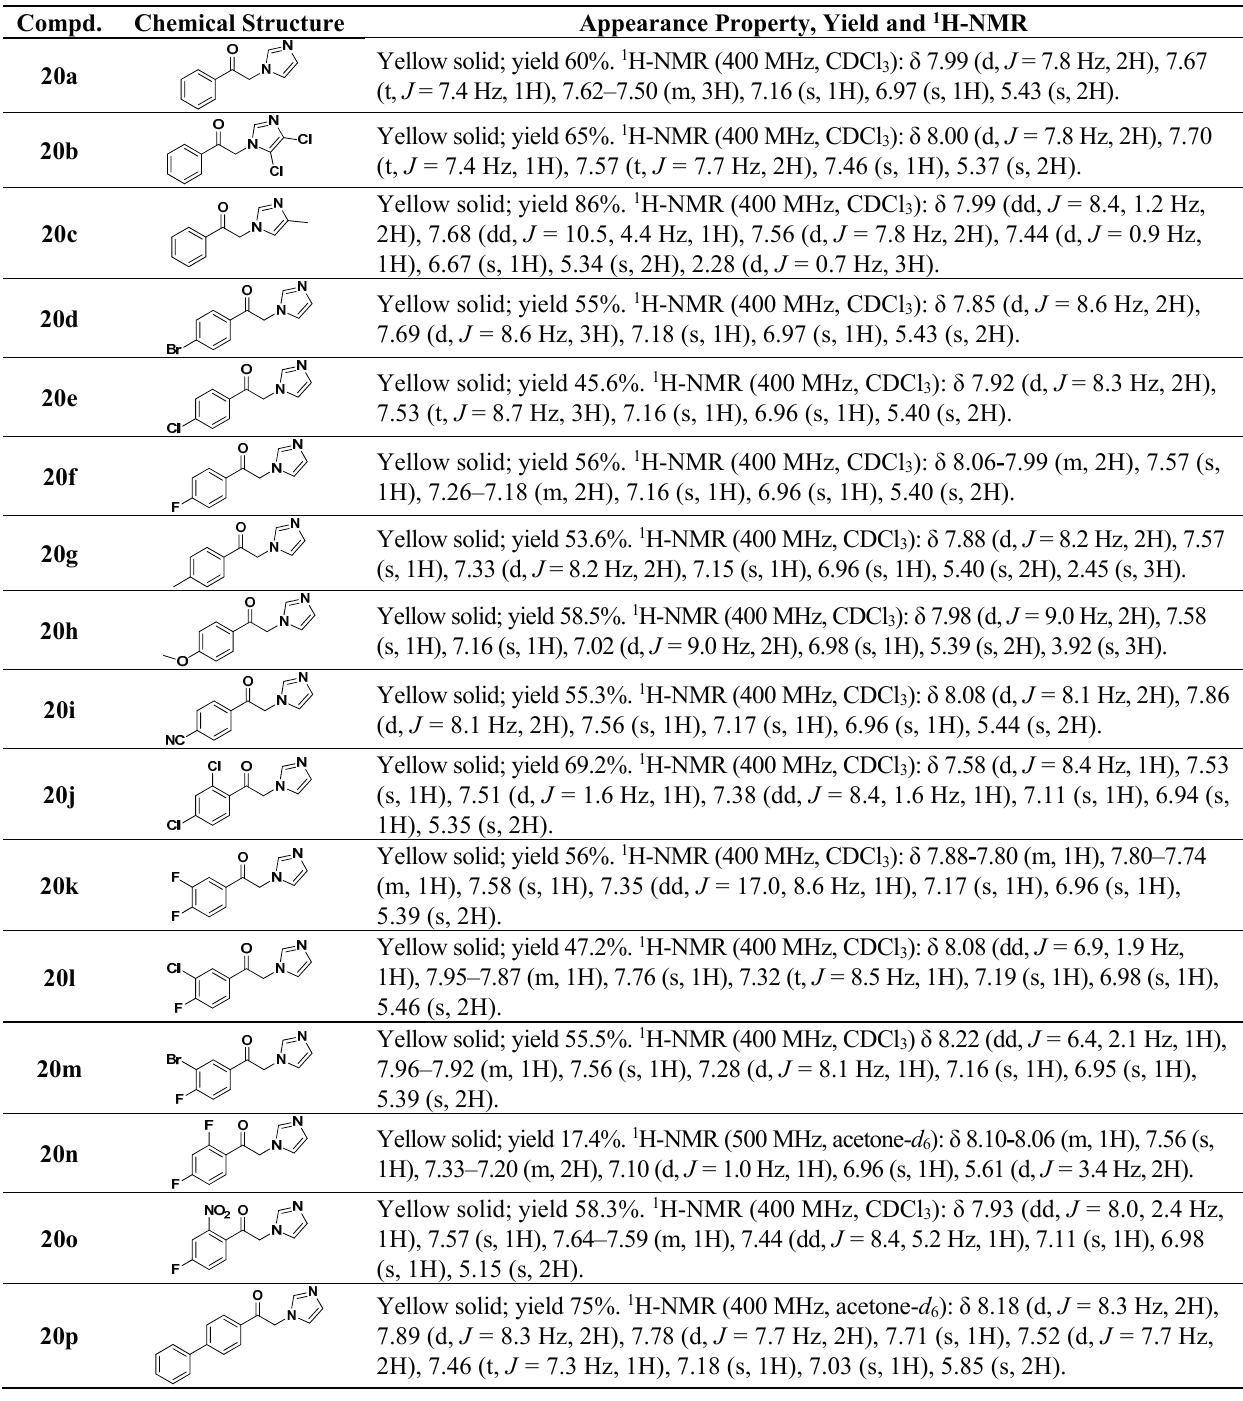
Table 5. The chemical structures, appearance, yields and 1 H-NMR of intermediates 20 . Compd. Chemical Structure Appearance Property, Yield and 1